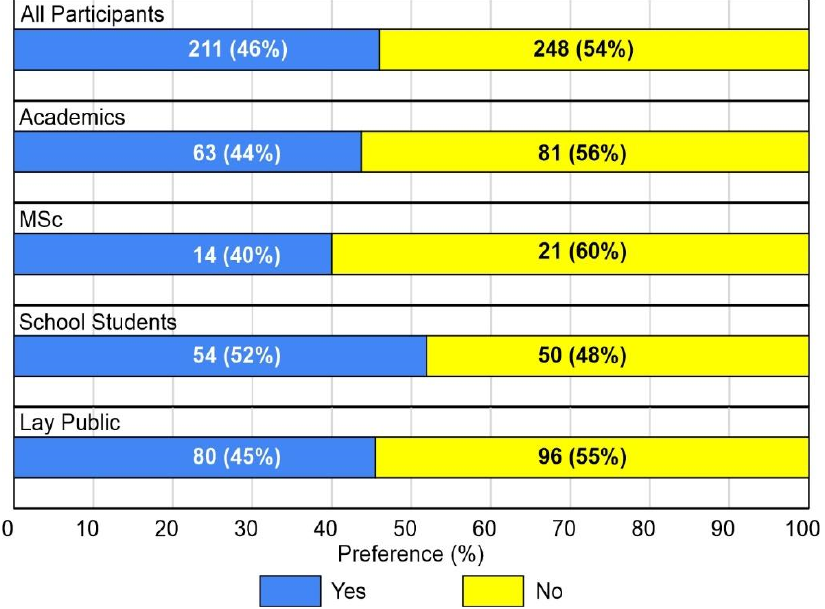
Figure 7. Bar charts showing the users’ familiarity with VR equipment before the dissemination events. The results represent both the total number of participants and the background of each group, respectively.